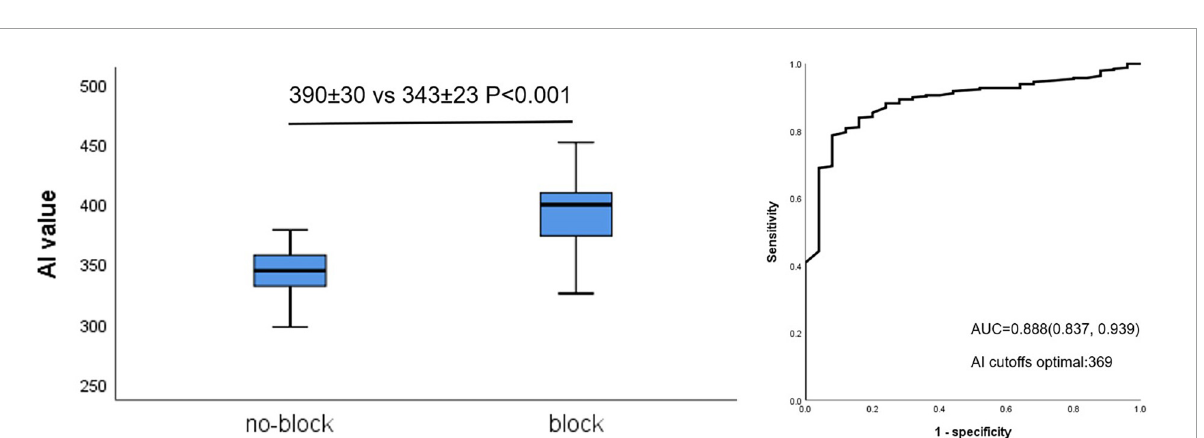
FIGURE2 The value of ablation index (AI) in different walls.